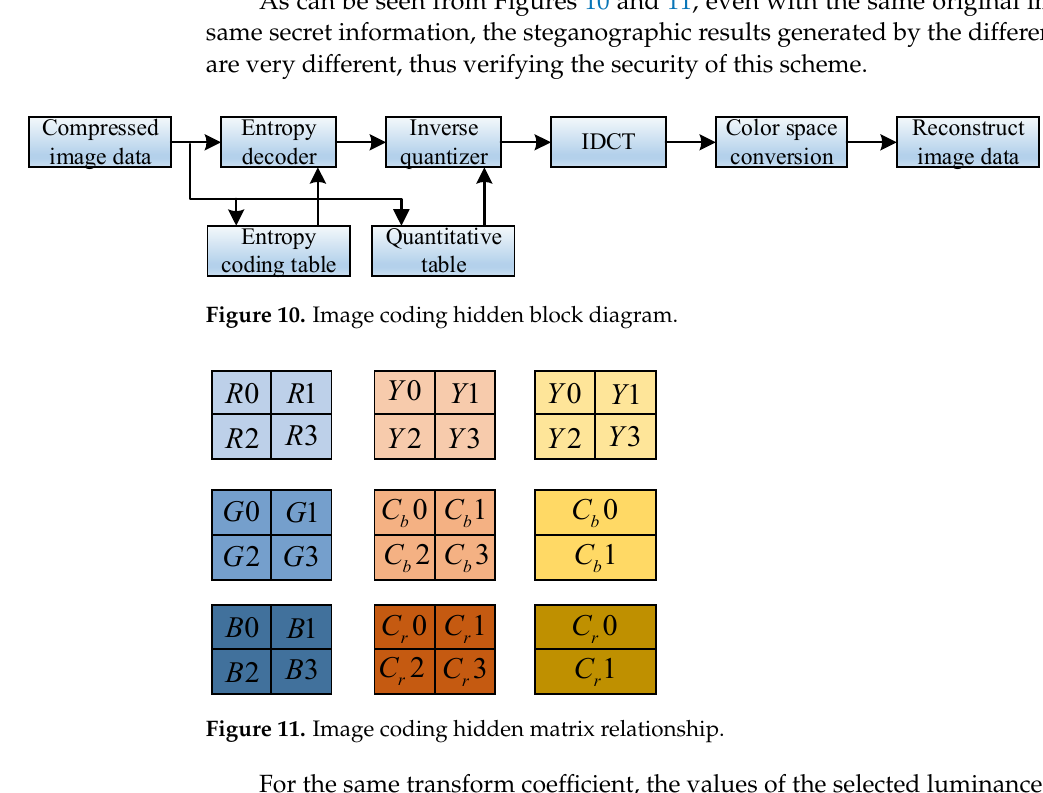
Table 9. Image coding hidden luminance quantization.